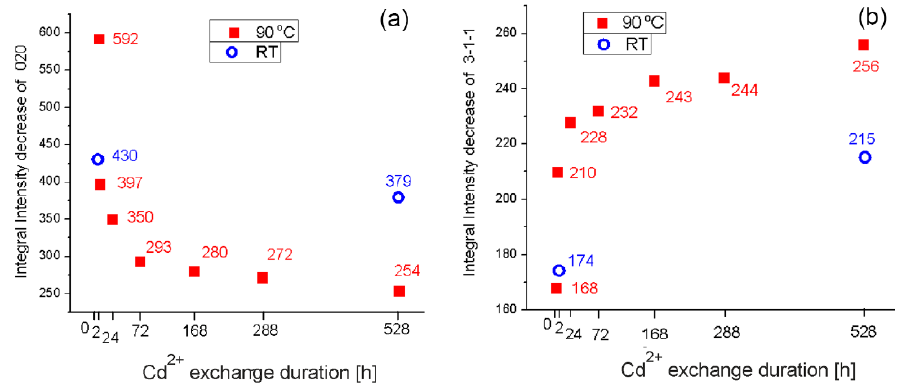
Figure 5. Integral intensities of 020 ( a ) and 31̅1̅ ( b ) peaks of Cd-clinoptilolite for different exchange times and temperatures.